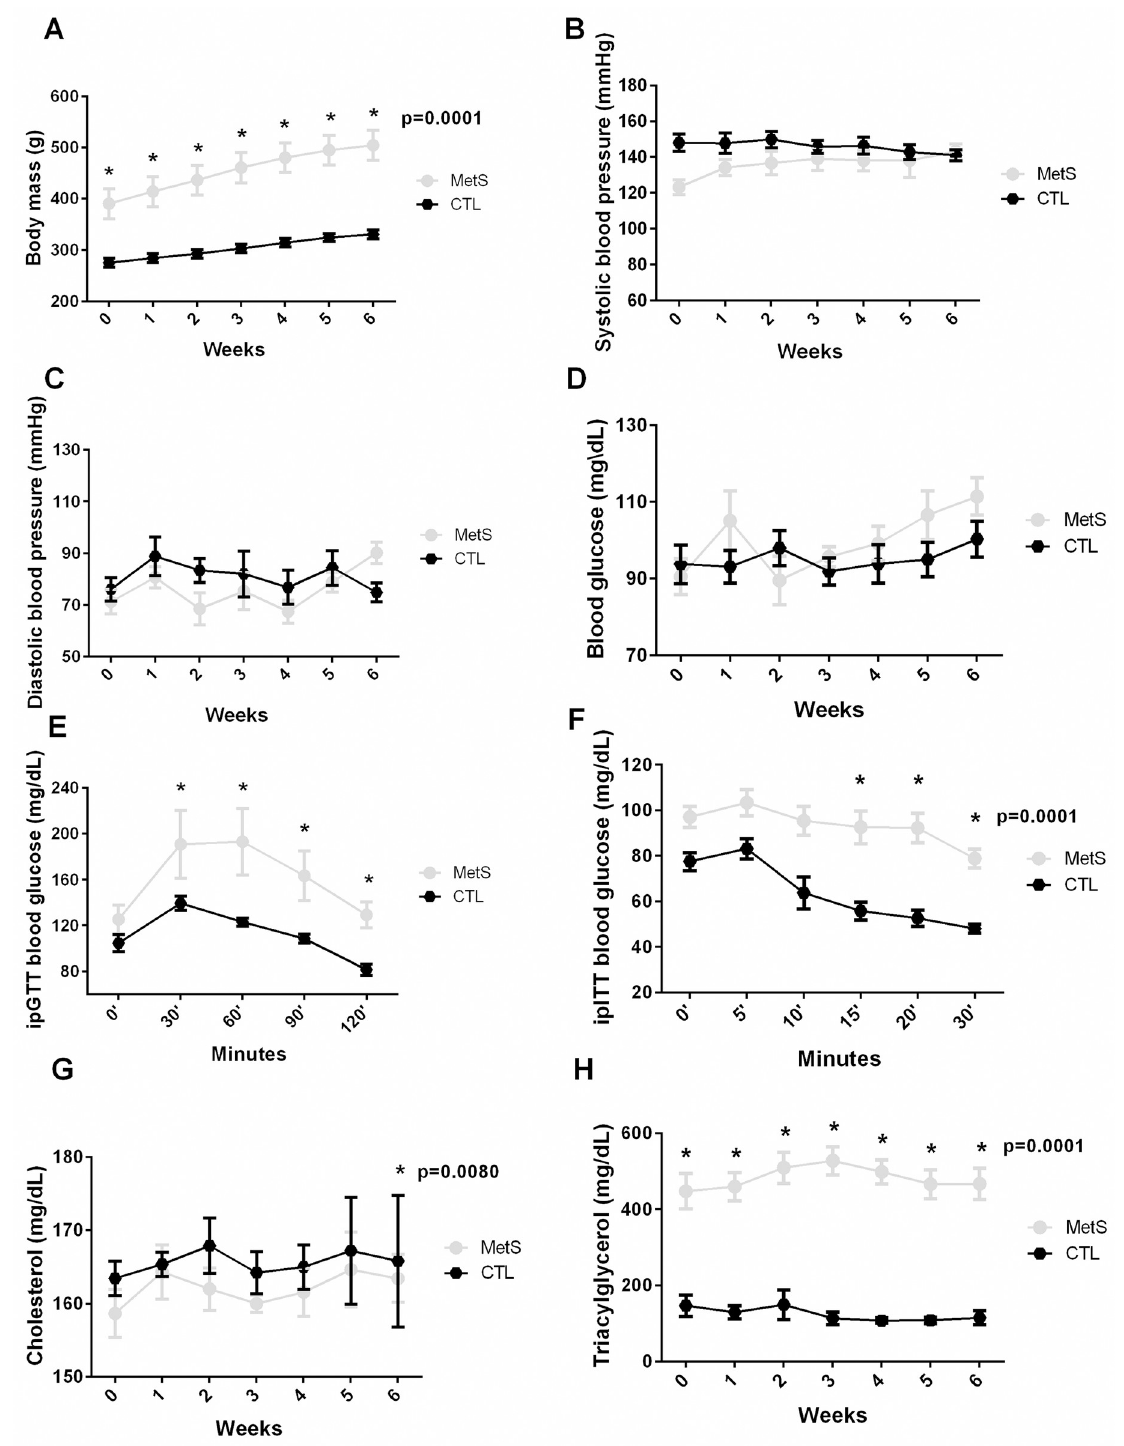
Fig 1. MetS diagnostic parameters—Control group. (A) body mass (g) (p = 0.0001), (B) systolic blood pressure (mmHg), (C) diastolic blood pressure (mmHg), (D) blood glucose (mg/dL), (E) ipGTT (minutes), (F) ipITT (minutes) (p = 0.0001), (G) cholesterol (mg/dL) (p = 0.0080), (H) Triacylglycerol (mg/dL) (p = 0.0001). � vs. CTL. Statistic: Two-Way ANOVA, p < 0.05.